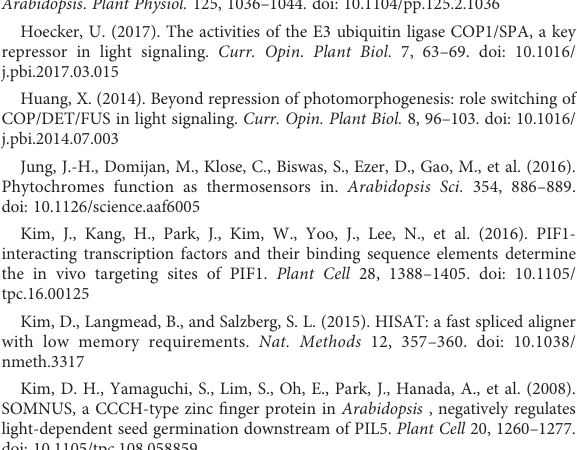
of genes enriched in the pathway, and the color of the cluster represents the con fi dence interval, and p -value was calculated from hypergeometric test.